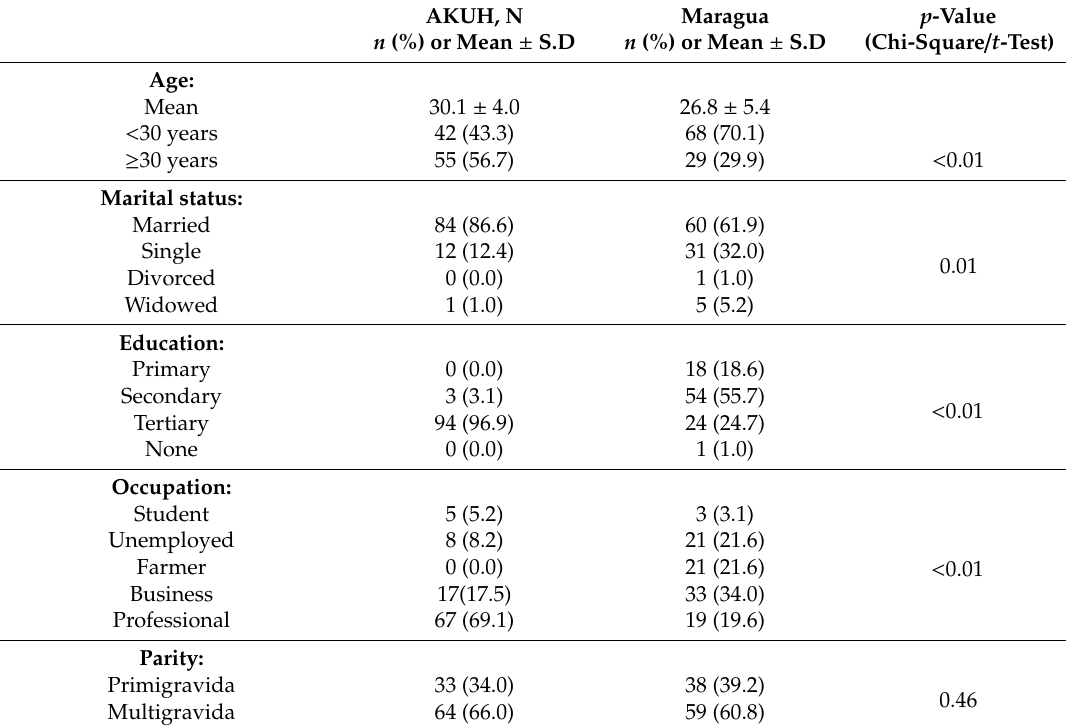
Table 1. Characteristics of study participants by